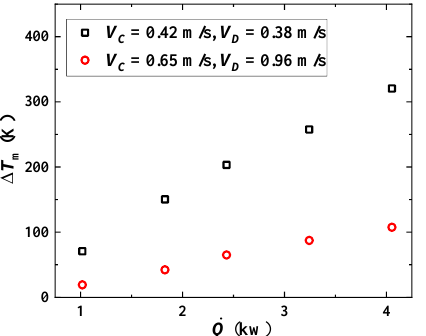
Figure 8. The maximum temperature rise varies with HRR ( φ = 0%). 3.2. Variation in Maximum Temperature Rises with Blockage Ratios in the Interconnected Tunnel At a certain ventilation velocity, the maximum temperature rise increased with the blockage ratio for the 0%, 10%, and 20% blockage ratios, as shown in Figure 9. Behind the blockage, the wind created a vortex area. Because the wind flow created a vortex area behind the obstruction when the blockage was located upstream of the fire, it resulted in a slowed local velocity and enhanced thermal feedback of the fire source, as well as an increase in the maximum temperature. The length and size of the vortex would have steadily risen as the blocking ratio increased [21]. When the blockage ratio was 30%, it was rather high; when the blockage ratio was increased, velocity increased, but the maximum temperature rise was reduced. Who was more impacted by the vehicle blockage ratio or velocity determines the maximum temperature rise in the interconnected tunnel. According to the analysis of 3.1, the velocities of ramp C and ramp D jointly affected the maximum temperature rise of the interconnected tunnel. The change in the maximum temperature rise from velocity Scheme 1 to 6 shows that as the velocity increased in the interconnected tunnel, convective heat transfer near the fire source increased, resulting in a decrease in temperature and a decrease in the effect of the blockage ratio on the maxi- mum temperature rise.